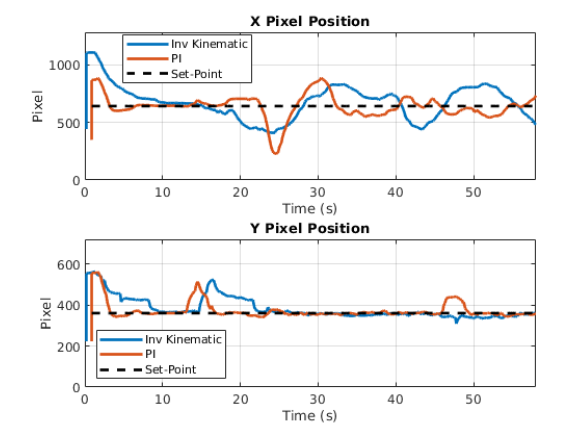
Figure 14. Comparison of pixel position using Inverse Kinematic and PI